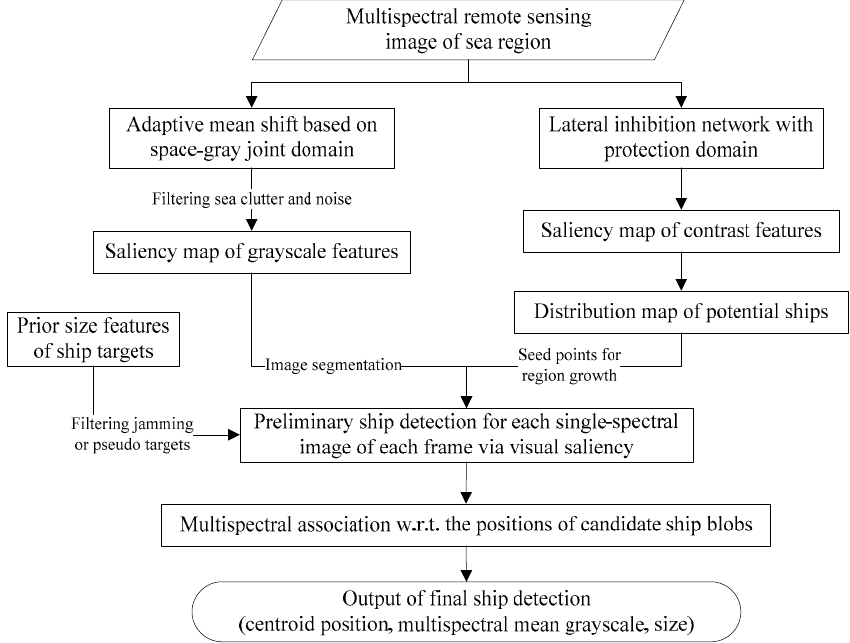
Figure 4. The whole work fl ow of the proposed dim small ship target detection method.